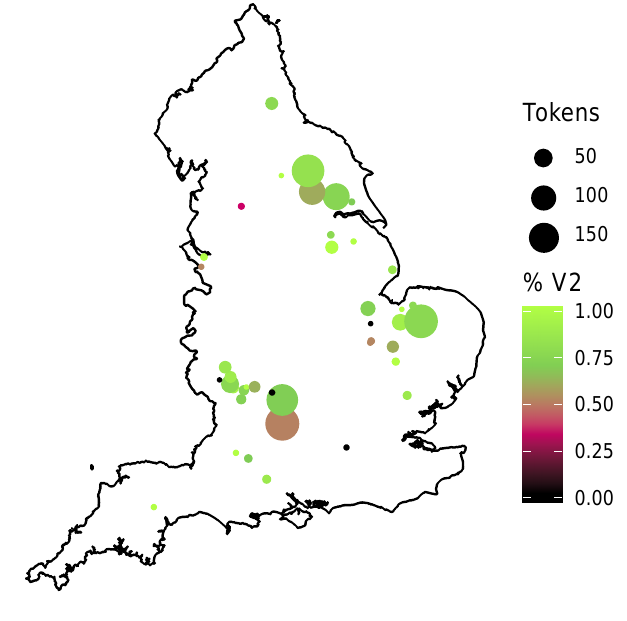
Figure 2. Rate of inversion in nonsubject‑initial sentences with full NP subjects, all PLAEME texts. In contrast, Figure 3 represents the rate of inversion with pronominal subjects. Al‑ though inversion with pronominal subjects is not categorically present in any large text in PLAEME, it is almost completely absent in southwestern texts, and observable to different extents in texts produced in the Danelaw. This suggests that Kroch and Taylor are at least approximately correct in identifying inversion with pronominal subjects as a distinctively northern characteristic. However, this pattern, which they identified in more or less ‘pure’ form in the Rule of St. Benet , is not strictly northern but instead found, to differing extents, in most of the Danelaw.